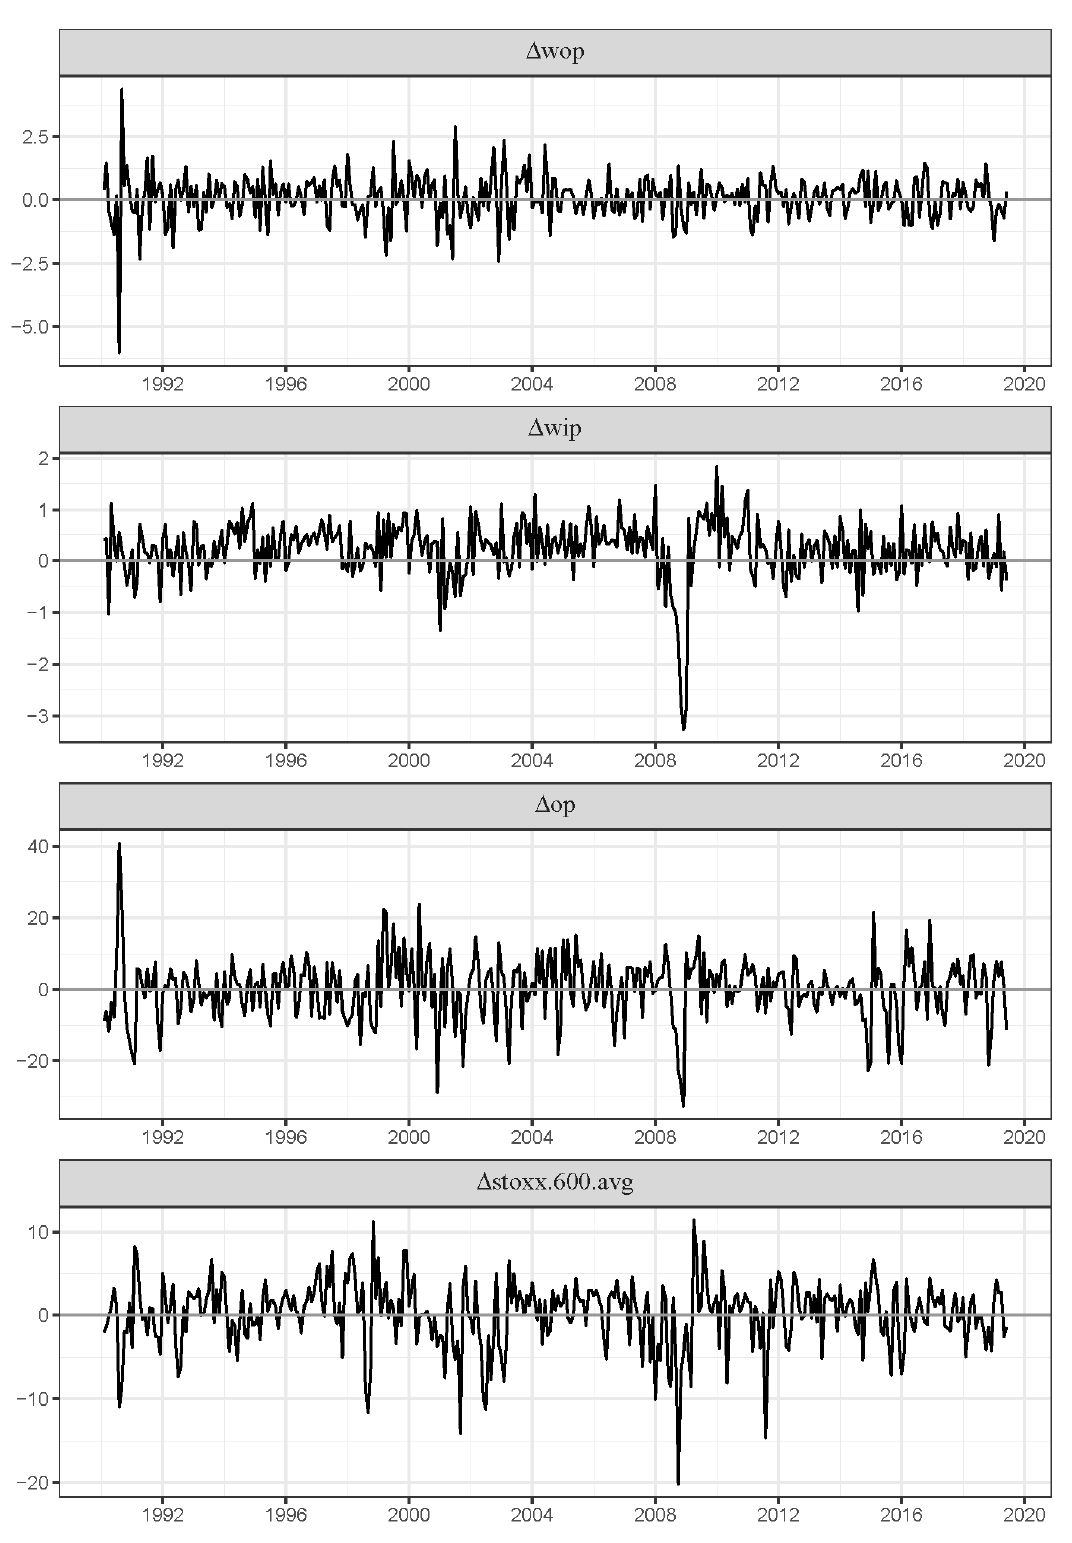
Figure A2. Evolution of returns. Note: This figure shows the evolution of returns on world oil production, world industrial production, oil prices and the STOXX Europe 600 stock market index.